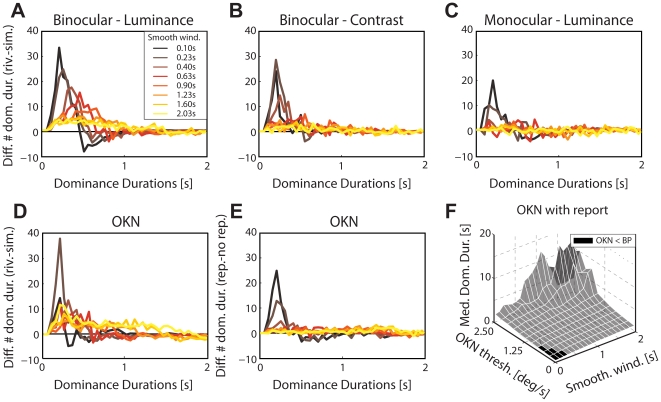
Parameter settings and dominance durations.(A–D) Difference between dominance-duration histograms for real-rivalry and simulated-rivalry based on pupil data (experiment 2, panels A–C) or OKN data (experiment 3, panel D) for different widths of the smoothing window applied to the raw trace. For each parameter setting, histograms were computed separately for dominance durations in real rivalry and simulated rivalry with the same binning (25ms bins). Histograms were then subtracted bin-wise; positive values imply that the respective bin (i.e., dominance duration) contained more incidences in the rivalrous condition as compared to the simulated condition, and negative values imply the converse. For short smoothing windows an abundance of short dominance durations is observed in real rivalry. This suggests that there exist short dominance durations in real rivalry that go unreported by the observers (see text). (E) Difference between dominance-duration histograms between report (active) and no-report (passive) trials based on OKN (experiment 3) and their dependence on the smoothing window. Histograms were subtracted bin-wise (25 ms bins); positive values indicate that the respective dominance-duration bin contains more incidences in the report condition than the no-report condition. (F) Median OKN-based dominance duration as a function of smoothing window and OKN sign change threshold. Black patches indicate when OKN-based dominance durations were significantly shorter than button-press-based dominance durations. In real-rivalry trials there is no ground truth as to whether transitions-based on pupil and OKN-are veridically identified. However, for a wide range of smoothing parameters there is only a small or no difference in such pupil and OKN-based dominance durations and those obtained from the button presses. For short time windows on the smoothing filter of the reflexive measurements and low thresholds, however, we observe significantly shorter dominance durations based on reflexes than based on button presses for rivalrous and reported trials as compared to simulated and unreported trials, respectively. This possibly reflects the difficulty for short dominance durations to be reported (see text). These data leave us confident that pupil and OKN sign changes are a reliable indicator of transitions in rivalry and may provide access to short dominance durations that observers cannot consciously report.